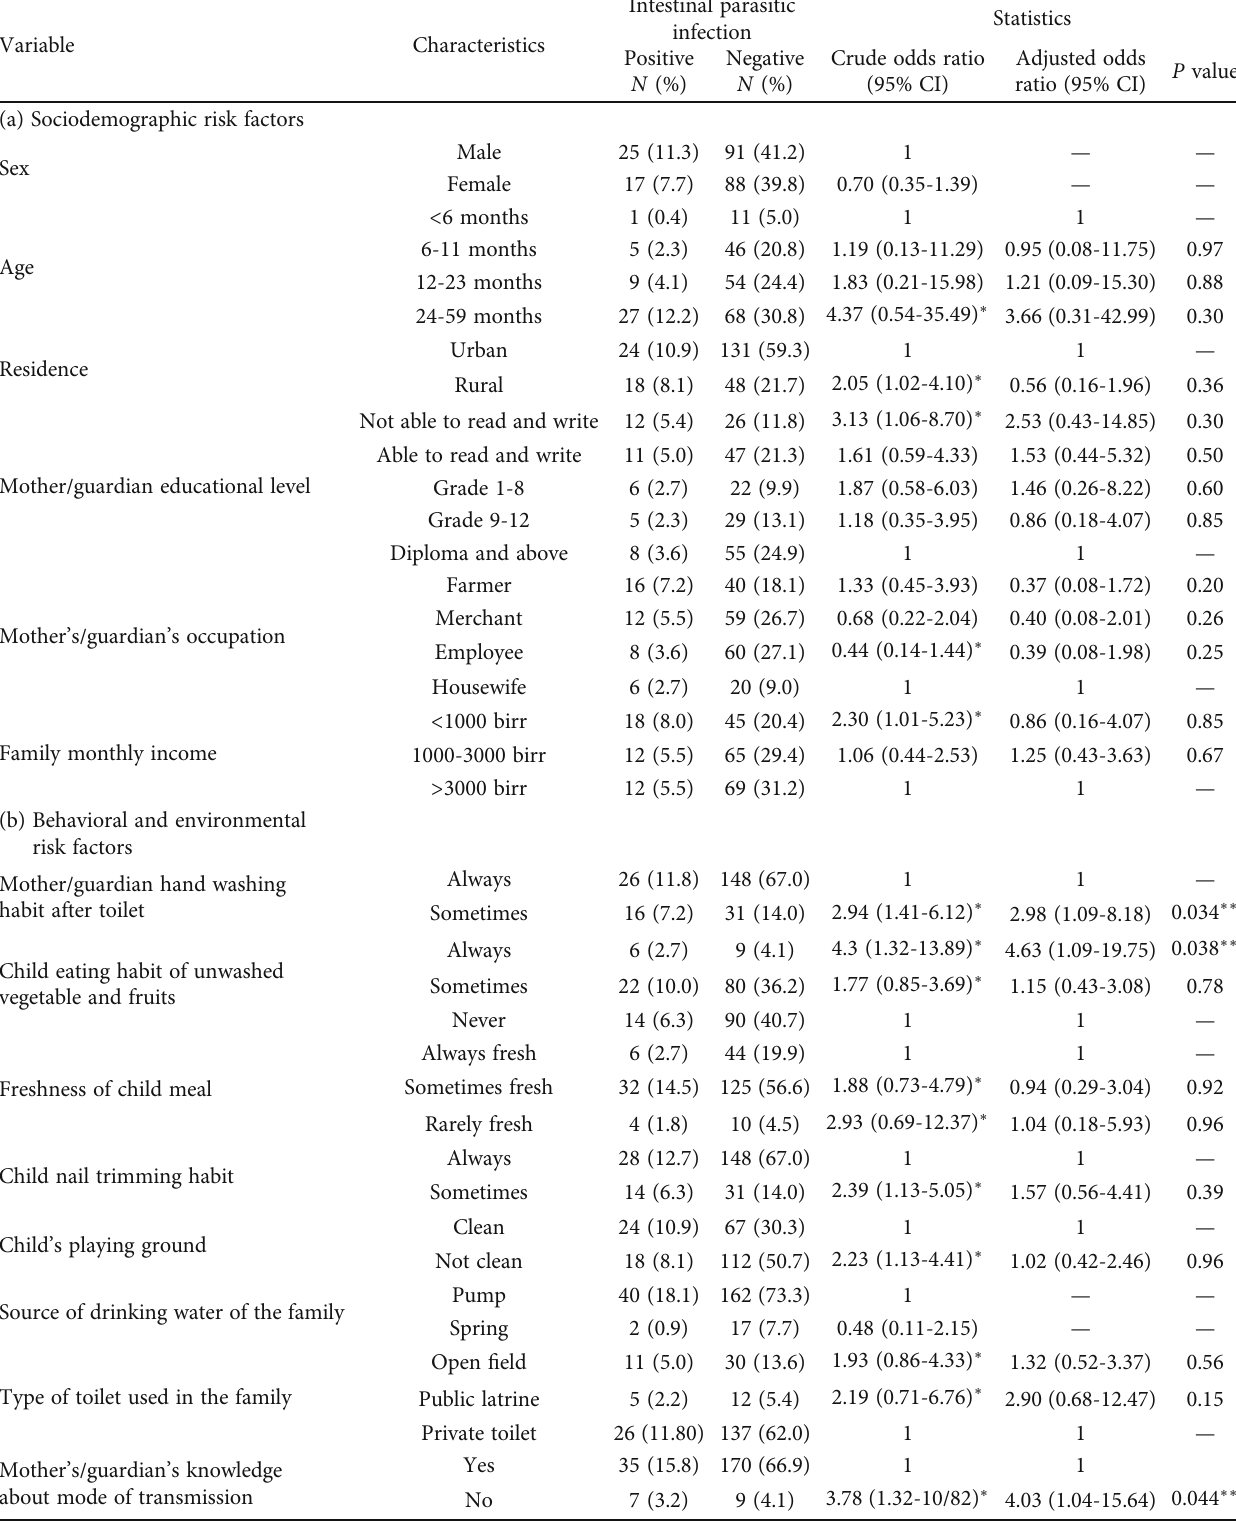
Table 2: Bivariable and multivariable logistic regression analysis of risk factors for IPIs among Bahir Dar and Han Health Centers, Northwest Ethiopia,